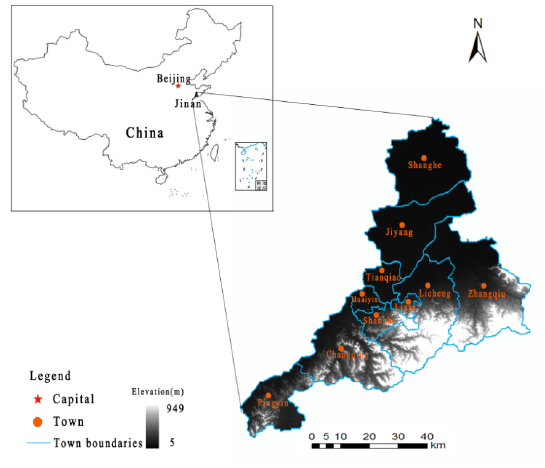
Figure 1. Location and administrative divisions of Jinan